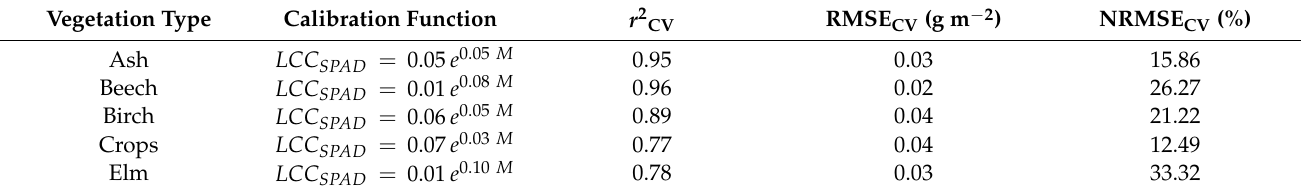
Table A1. Calibration functions relating SPAD-502 values to spectrophotometrically-determined LCC in g m − 2 and associated performance statistics derived though leave-one-out